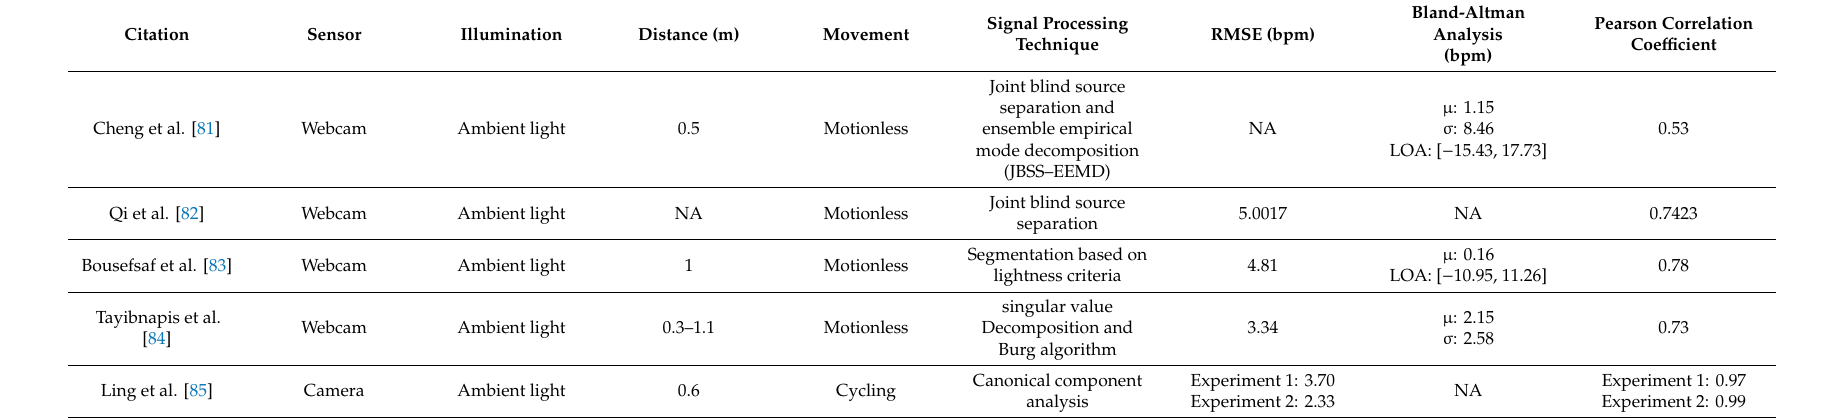
Table 8. Summary of PPGI techniques for HR monitoring, part